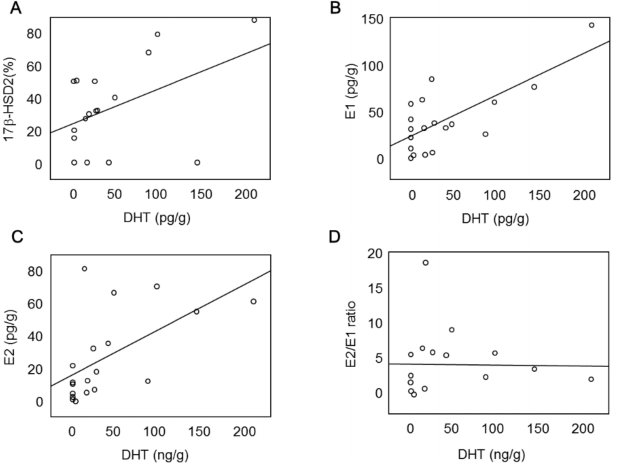
Figure 4. ( A ) Correlation between 17 β -HSD2 (%) and intratumoral DHT concentration (pg/g) in 19 endometrioid endometrial adenocarcinoma cases. ( B – D ) Correlation between intratumoral DHT and E1 ( B ), E2 ( C ) concentrations (pg/g) or E2/E1 ratio ( D ) in 19 endometrioid endometrial adenocarcinoma